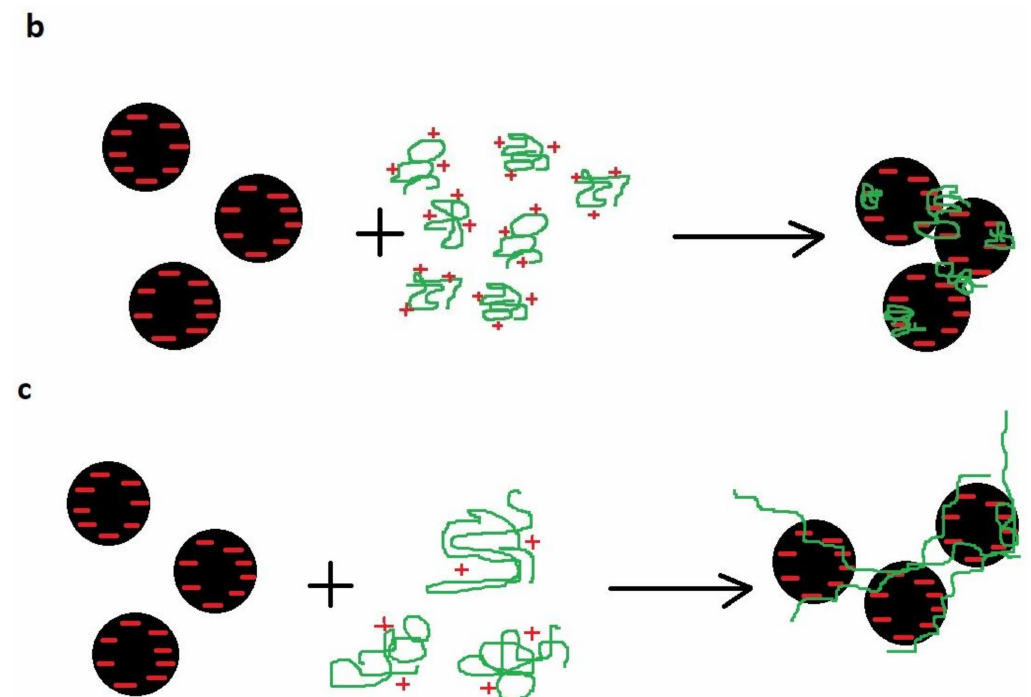
Figure 1. Mechanisms of flocculation: ( a ) charge neutralization; ( b ) patching; and ( c )